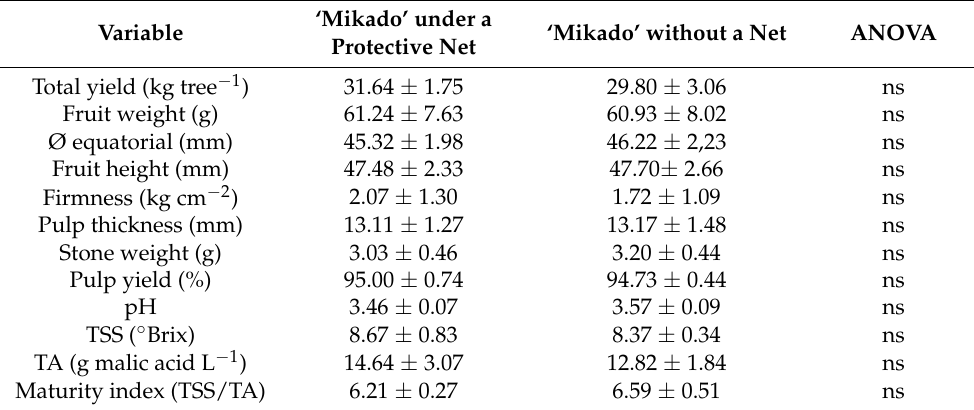
Table 1. Physical and chemical properties of ‘Mikado’ apricot cultivar grown under a protective net and without a net. Mean values ± standard deviation ( n =